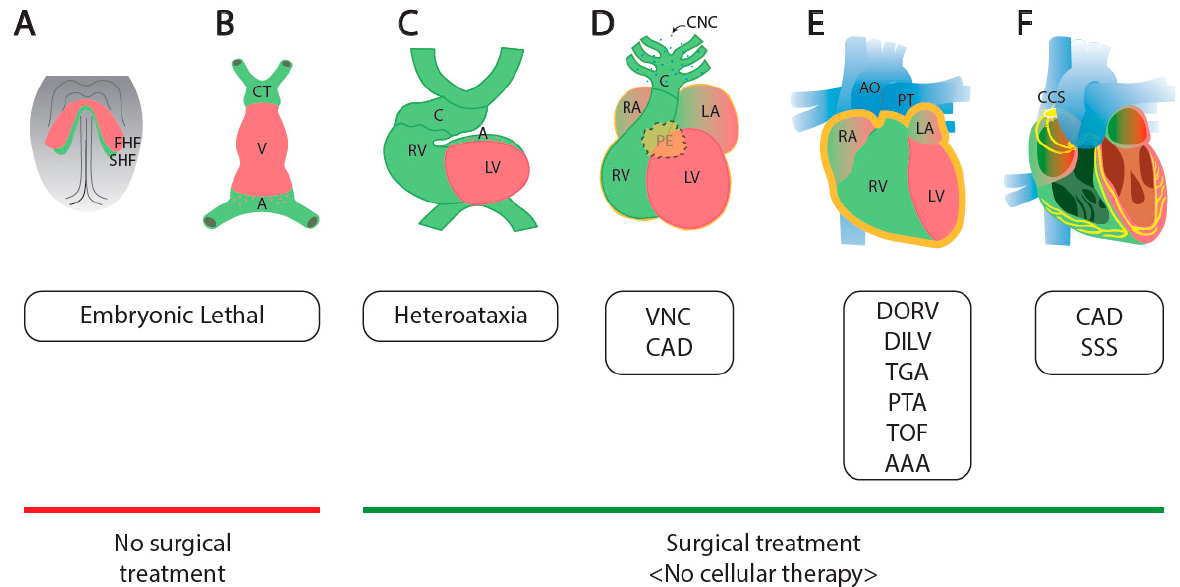
Figure 1. Schematic representation of the main steps of cardiogenesis. Starting from the cardiac crescent ( A ) into the cardiac straight tube ( B ), followed by the rightward looping ( C ). Soon thereafter, atrial and ventricular chambers are configured ( D ) with the contribution of extracardiac cells such as the proepicardial derived cells that externally lined the naked embryonic myocardium ( D ) and septation occurs leading to a four-chambered heart ( E ) with its own electrical wiring, i.e., the cardiac conduction system and vascular supply, i.e., coronary vasculature ( F ). VNC, ventricular non-compaction, CAD, coronary artery disease, DORV double outlet right ventricle, DILV double inlet left ventricle, TGA, transposition of the great arteries, PTA, permanent truncus arteriosus, TOF, tetralogy of Fallot, AAA, aortic arch abnormalities, SSS, sick sinus syndrome. Soon after cardiac rightward looping takes place, embryonic atrial and ventricular chambers emerge that are interconnected between them by flanking segments such as the inflow tract, the atrioventricular canal, and the outflow tract [13]. These flanking segments are characterized by the presence of endocardial cushions, that are more prominent in the atrioventricular canal and outflow tract as compared to the inflow tract [13] (Figure 1). Importantly, the configuration of these cardiac chambers emanates from two distinct cell populations, namely the first and second heart fields, respectively [14,15]. While the first heart field primarily contributed to the future left ventricle, the second heart field contrib- utes to the rest of the cardiac chambers, i.e., in the anterior part of the heart to the future right ventricle and outflow tract and in the posterior part of the heart to the atrioventric- ular canal, embryonic right and left atria and the inflow tract. Impaired deployment of the second heart field leads to congenital heart defects that are incompatible with life, as the outflow tract, the right ventricle, and much of the atrial chambers are missing [16]. Configuration of the embryonic cardiac chambers further develops by a progressive external lining of the naked embryonic myocardium with the embryonic epicardium and by the progressive formation of distinct ventricular myocardial layers, i.e., the trabecular and compact layers (Figure 1). Both processes are intimately related as if no epicardial lining occurs, the ventricular compact myocardium fails to properly develop [17,18] re- sulting in a phenotype reminiscent of the ventricular non-compaction defect in adult hu- man patients [19,20]. Importantly the contribution of the embryonic epicardium goes far beyond merely externally lining the myocardium, in such a way that epicardial-derived cells contribute to the fibroskeleton of the heart, the forming cardiac valves, and more